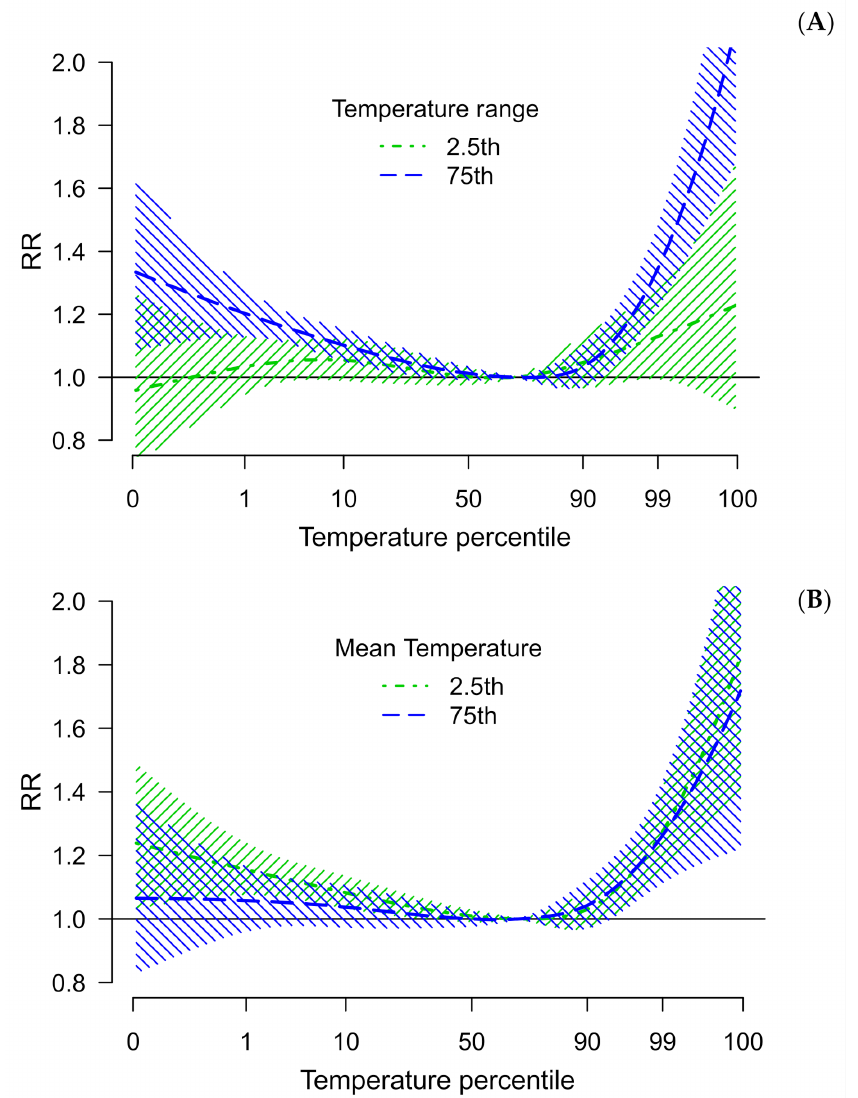
Figure 3. Pooled overall cumulative exposure–response association curve between Table 2. 5th and 75th percentiles of the meta-variables temperature range ( A ) and mean ( B ). Brazil, capitals, 2000 to